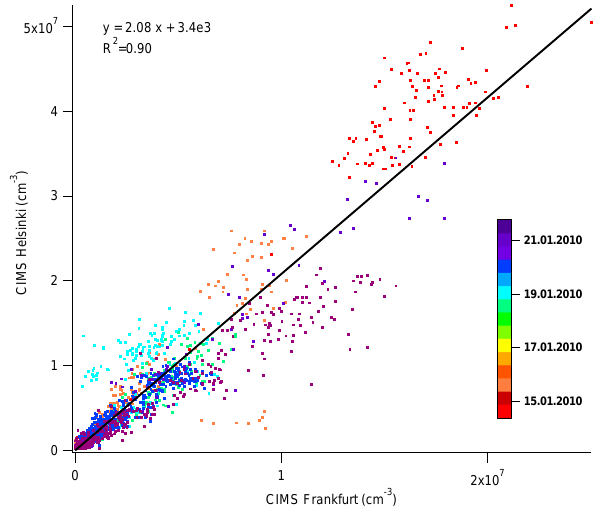
Fig. A2. Correlation between the H 2 SO 4 measurements of the two CIMS color coded by